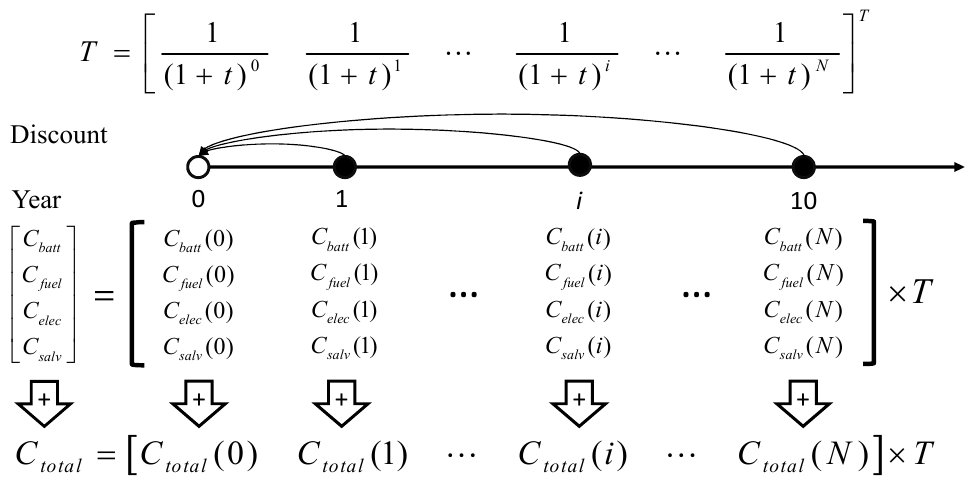
Figure 2. The cash flows and